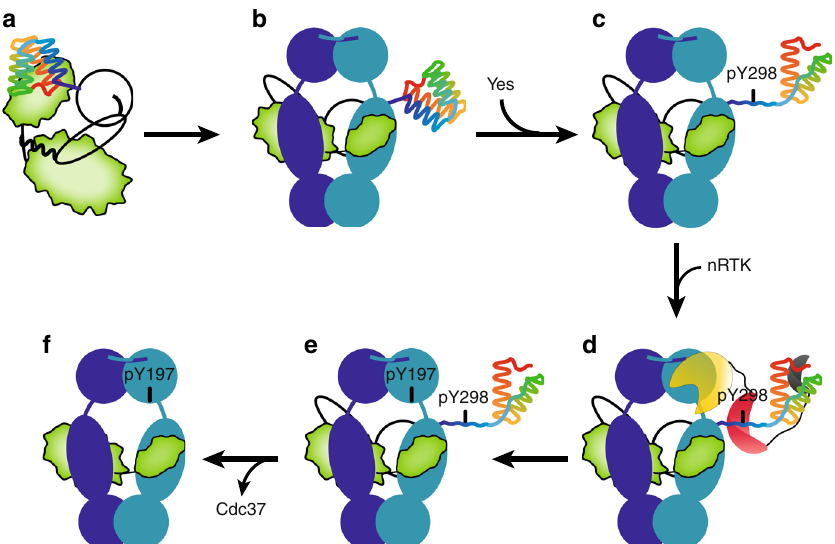
Fig. 7 Targeted-Hsp90 phosphorylation via a cochaperone-recruited kinase. a , b Client kinases require Cdc37 to form stable complexes with Hsp90 in the beginning of the chaperone cycle. c , d Partial unfolding of C-Cdc37 upon Y298 Cdc37 phosphorylation creates a high-af fi nity SH2-interacting motif, which recruits nRTKs to the Hsp90 complex. e , f nRTKs phosphorylate Hsp90 at Y197, resulting in dissociation of Cdc37 and progression of the Hsp90 cycle. Cochaperone-mediated recruitment of modifying enzymes may be a generalized mechanism to create unique Hsp90 phosphorylation patterns in a client class-speci fi c manner or alternatively to modify clients (Hsp90, Cdc37, and client kinase are shown in blue, black outline, and green, respectively). The helical C-Cdc37 is shown in rainbow from blue to red. The kinase, SH2, and SH3 domains of the modifying nRTK are shown in yellow, red, and gray,